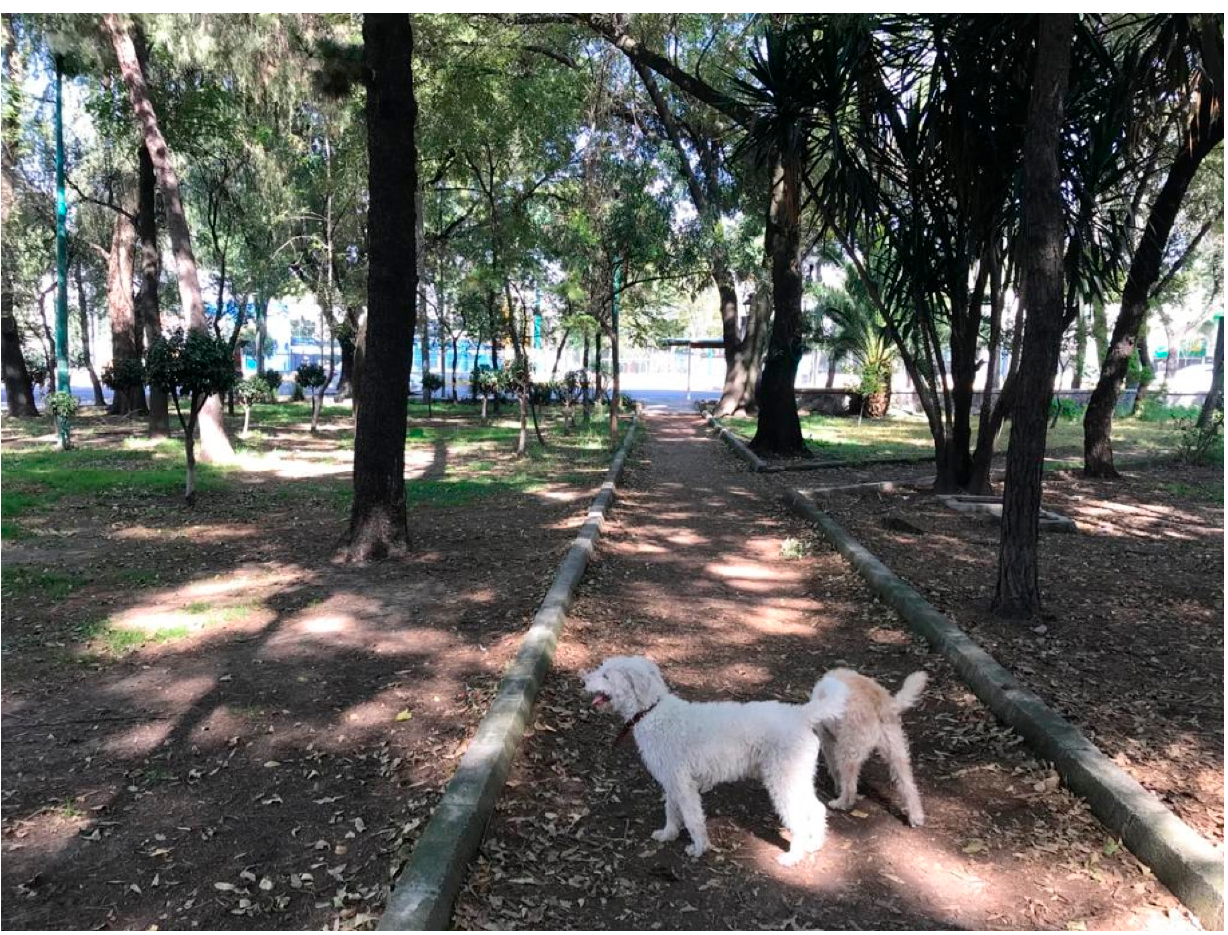
Figure 2 . One of the three UGSs near Participant 1’s home. Figure 2. One of the three UGSs near Participant 1’s